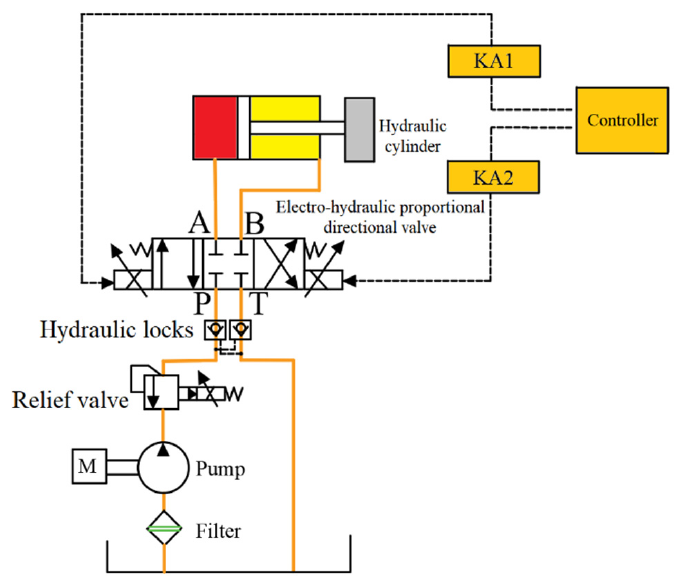
Figure 6. Working principle diagram of the hydraulic system. Note: KA1 and KA2 are electromagnetic relays; A and B are the actuators of the hydraulic system working oil port; P is the hydraulic system actuating element oil intake port; T is the hydraulic system actuating element oil outlet port; M is the hydraulic motor of the hydraulic